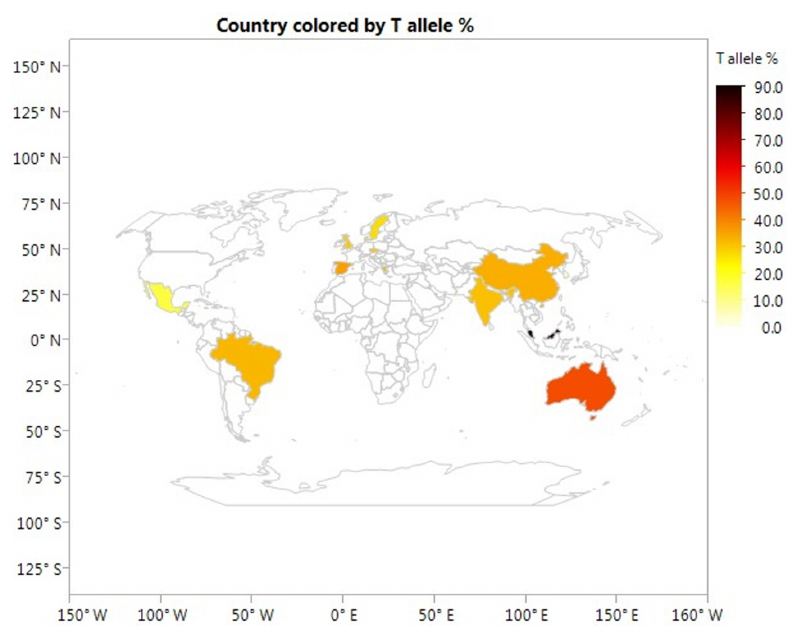
Fig 3. Geographic distribution of risk T allele of rs7903146 polymorphism stratified by study country. The color bar on the right corresponds to the respective allele frequency map (10% interval). This global map showing geographical distributions of the risk T allele frequency was generated using JMP Statistical Discovery software (Version 12 SAS institute Inc., Cary, NC).